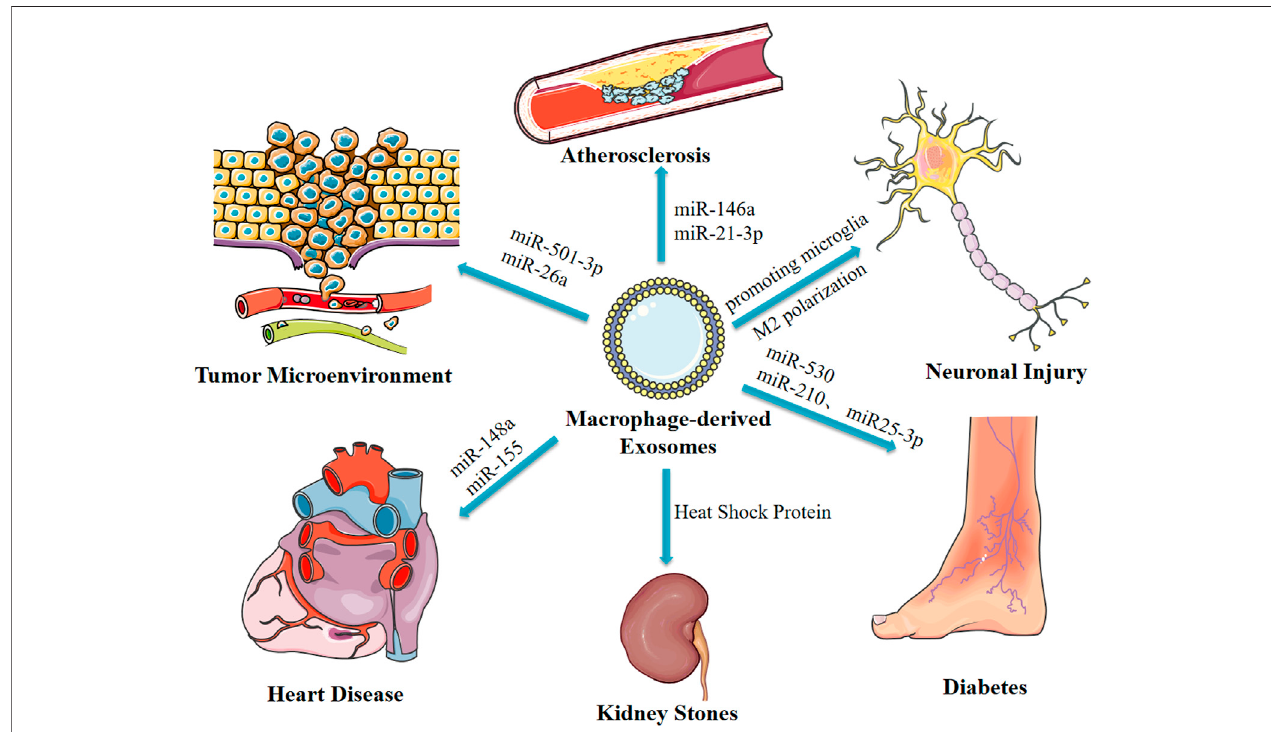
FIGURE 3 | Macrophage-derived exosomes affect disease progression through delivery of miRNAs and other pathways.